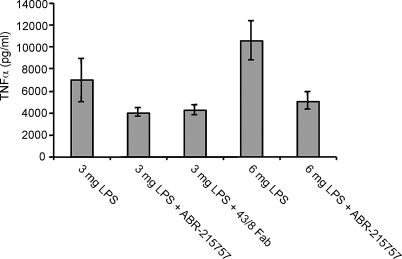
Inhibition of TNFα Induction by 43/8 Fab and ABR-215757C57BL/6 mice were treated with PBS, 43/8 Fab, or ABR-215757 for 2 h before being challenged with 3 or 6 μg of LPS intraperitoneally, as indicated. Two hours after LPS challenge, the animals were sacrificed, and the level of TNFα in serum was determined. Error bar indicates standard error of the mean (SEM).